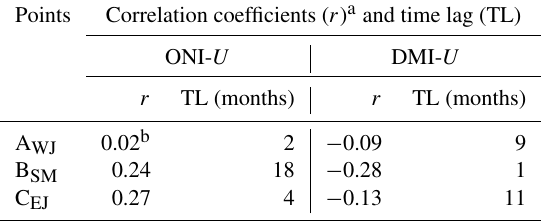
Table 4. Lag correlation between the zonal currents at 30m and each ONI and